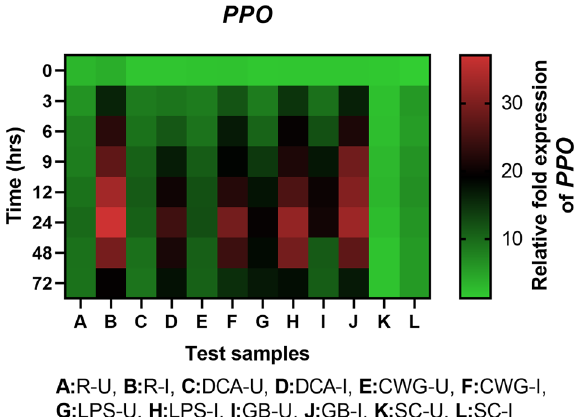
Figure 9. qRT-PCR determined relative expression of PPO genes in 2-day-old P. glaucum seedlings with (I) or without (U) Sclerospora graminicola inoculation harvested 0, 3, 6, 9, 12, 24, 48, and 72 h. R—resistant, S— susceptible, DCA—3,5-Dichloroanthranilic acid treated, CWG—Cell Wall Glucans isolated from the endophyte Trichoderma hamatum UOM 13, LPS—Lipopolysaccharides isolated from bacteria Pseudomonas fluorescens UOM 14, GB—Glycinebetaine an amino acid derivative. Expression levels were measured by qPCR and normalized to the constitutive PP2A gene. Values are means of experiments carried out in four replicates. The bars indicate ± SE and the data were analyzed by one-way ANOVA followed by Tukey’s test and p ≤ 0.05.